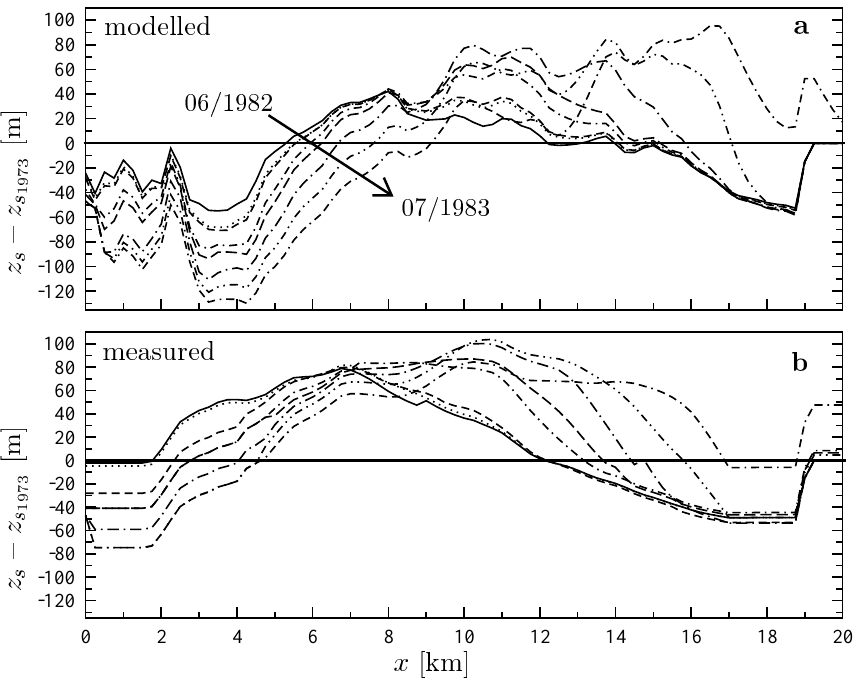
Fig. 10. Comparison of (a) modelled and (b) measured surface geometries relative to the 1973 surface topography for each date during the surge.